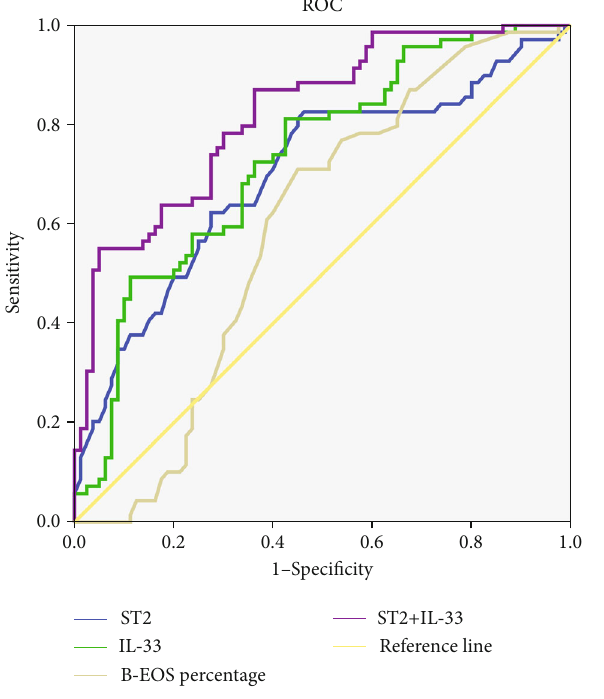
Figure 2: ROC curves of potential predictive variables for distinguishing CRSwNP endotypes. ROC: receiver operating characteristic; CRSwNP: chronic rhinosinusitis with nasal polyps; IL-33: interleukin-33; sST2: soluble suppressor of tumorigenicity 2; B-EOS: blood eosinophil.